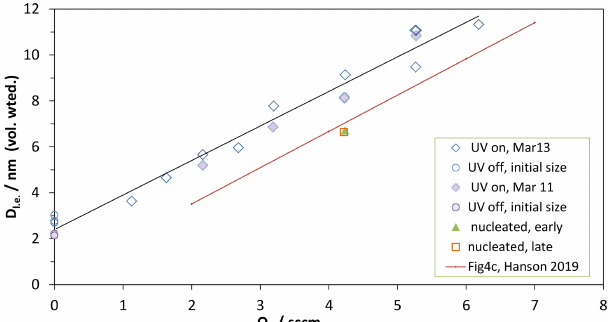
Figure 4. Growth studies of externally produced nanoparticles, D le vs. Q 4 . D le is the volume-weighted diameter of the leading edge of the size distribution. The nanoparticles’ initial size is indicated by the data plotted at Q 4 = 0sccm. The red line labeled “Fig4c” is from Hanson et al.